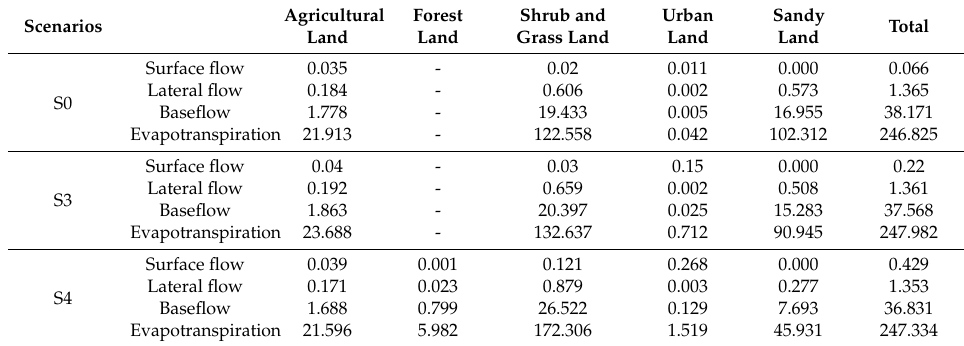
Table 9. The contribution of different land use types to the value of hydrological components under different land use scenarios